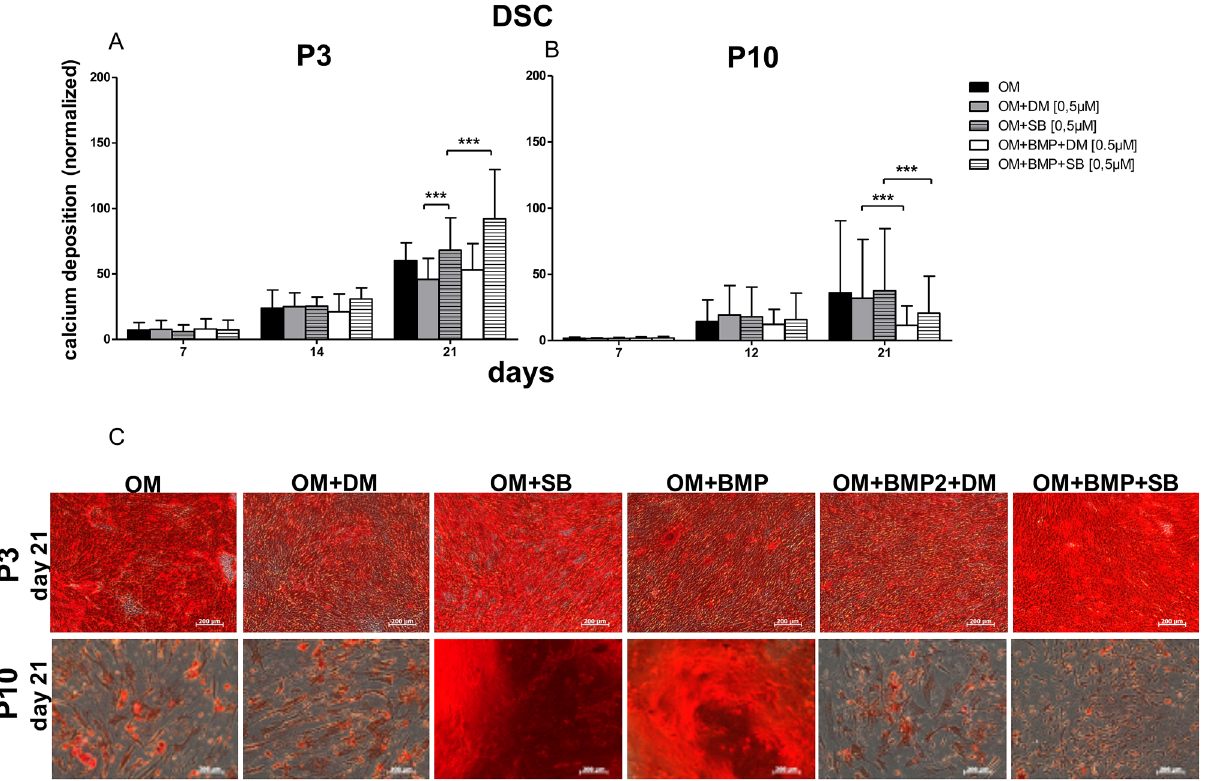
Figure 5. Comparison of the DSC osteogenic differentiation potential at P3 versus P10. ( A ) Evaluation of osteogenic differentiation potential at P3 with alizarin red s. At day 21 the inhibition of TGF-β signaling with SB431542 (OM + SB) was significantly superior to the inhibition of BMP-2 signaling with dorsomorphin (OM + DM). If TGF-β signaling was inhibited with SB431542 and the BMP-2 signaling was induced with BMP-2 (OM + BMP + SB) the osteogenic differentiation was significantly superior to a solely inhibition of TGF-β signaling (OM + SB). ( B ) Evaluation of osteogenic differentiation potential at P10 with alizarin red s. At day 21 the inhibition of TGF-β signaling in the course of osteogenic differentiation with SB431542 (OM + SB) was significantly superior to the inhibition of BMP-2 signaling with dorsomorphin (OM + DM), and superior (in the contrary to P3) to the inhibition of TGF-β signaling with SB431542 and inducing BMP signaling with BMP-2 (OM + BMP + SB). Additionally, the inhibition of the BMP-2 signaling with dorsomorphin (OM + DM) was superior to the osteogenic differentiation with dorsomorphin and BMP-2 (OM + BMP + DM). Black bars represent DSC differentiated with osteogenic standard differentiation media (OM). Grey bars demonstrate DSC differentiated with OM and dorsomorphin (OM + DM). Stacked grey bars are DSC differentiated osteogenically and treated with SB431542 (OM + SB). White bars are DSC coincubated with OM and BMP-2 with the inhibitor dorsomorphin (OM + BMP + DM). Stacked white bars are DSC differentiated with OM, BMP-2 and the inhibitor SB431542 (OM + BMP + SB). Bars represent mean ± SD of three donors. *** p < 0.001 as compared to the respective sample. ( C ) Visualized comparison of osteogenic differentiation potential of DSC at P3, and P10. Evaluation was performed with alizarin red s on day 21. Shown is one representative illustration of at least six identical results. The image scales represent a length of 200